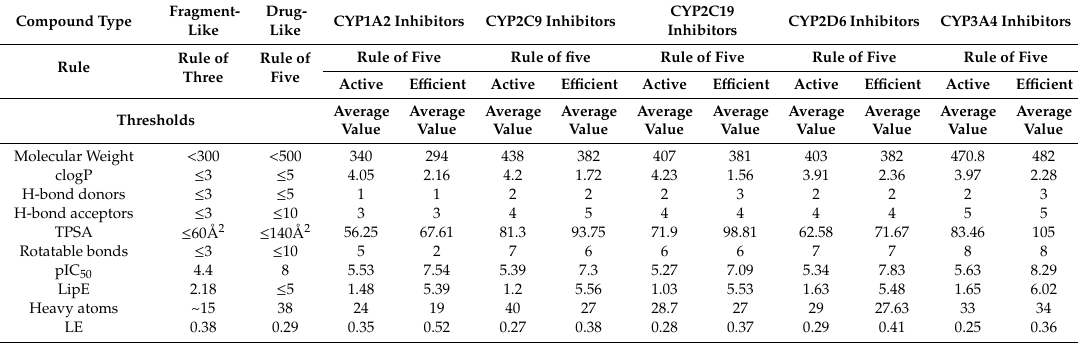
Table 5. The ranges and estimated average values of rule of five parameters and ligand e ffi ciency metrics for fragments, drug-like compounds and CYP1A2, CYP2C9, CYP2C19, CYP2D6 and CYP3A4 active and highly e ffi cient